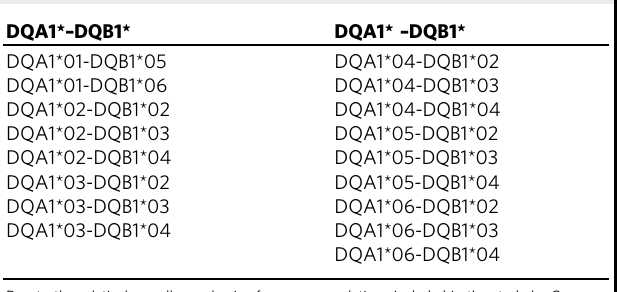
Table 1 List of DQA1-DQB1 haplotypes extracted from Creary et al. and Petersdorf et al. 13,14